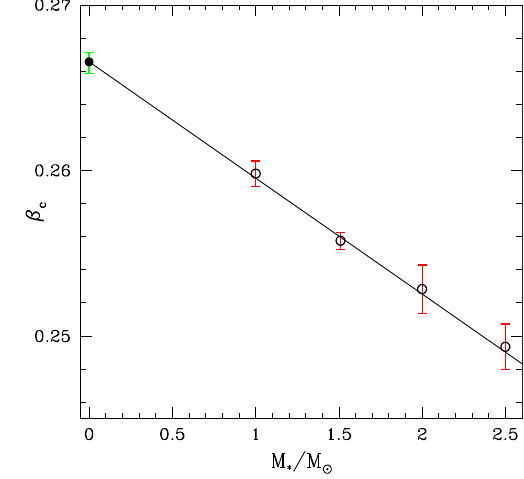
Fig. 27 The open circles represent the extrapolated β c as a function of the stellar rest-mass (for the masses considered the compactness also increases along the positive horizontal axis). The filled circle represents the Newtonian limit for β c . The plot corresponds to Γ = 2 polytropes. (Image reproduced with permission from Manca et al. 2007, copyright by